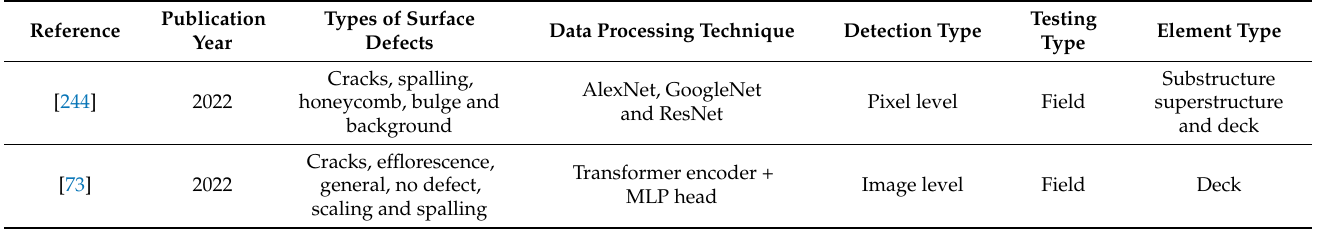
Figure 16. Distribution of detection types of surface defects. Table 19. Summary of some of the research studies on the classification of bridge surface